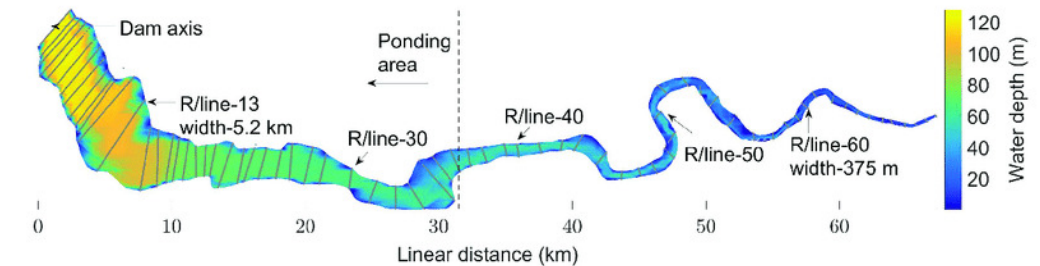
Figure 3. Range lines (R/Lines) of Tarbela Reservoir used from